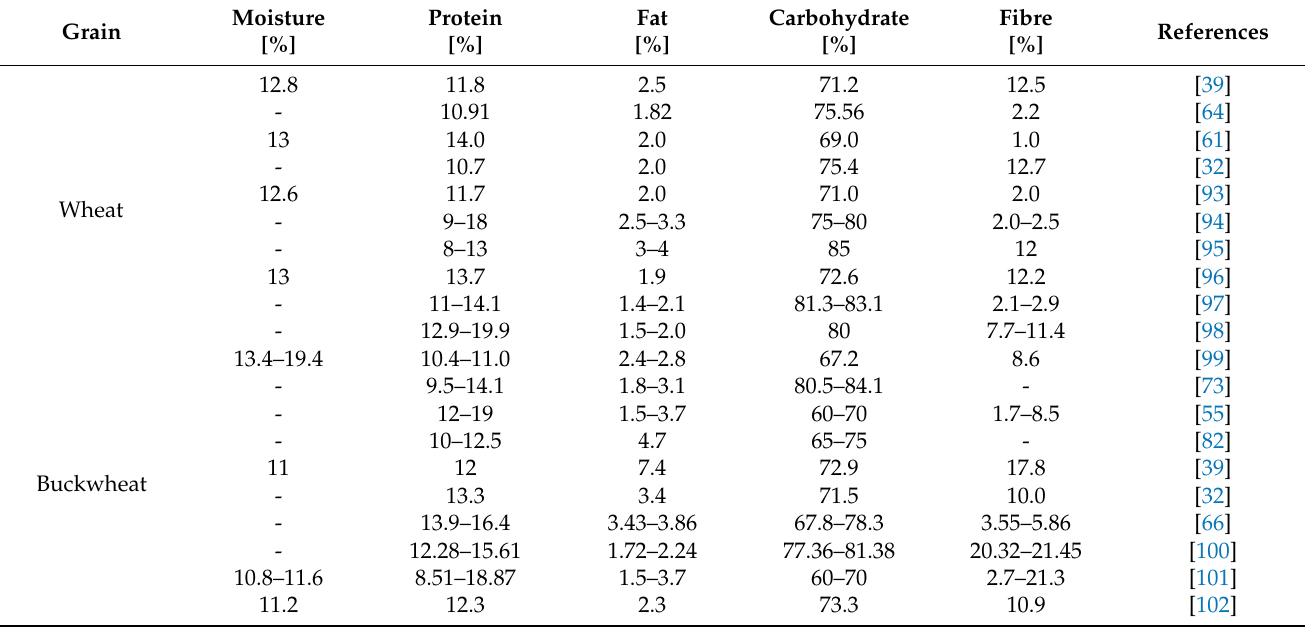
Table 1. Physico-chemical characteristics of buckwheat, amaranth, and